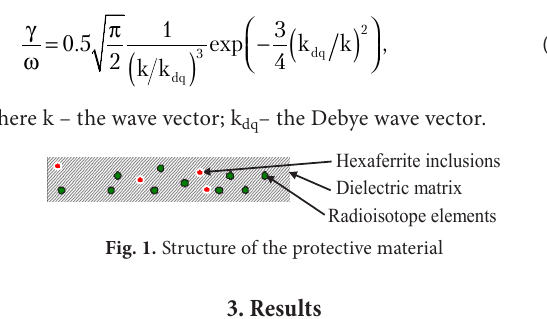
1. The case of a gaseous plasma medium. The dependence of the logarithm of the ratio of electron densities to the pulse amplitude for different pulse durations, obtained using (1), is shown in Fig. 2.